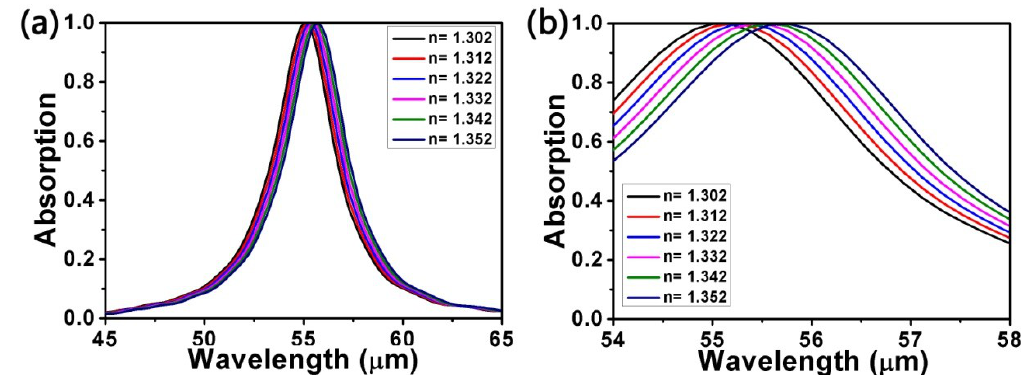
Figure 7. ( a ) Absorption spectra for different values of surrounding refractive index n . Other parameters are unchanged. ( b ) Local details of absorption peaks.